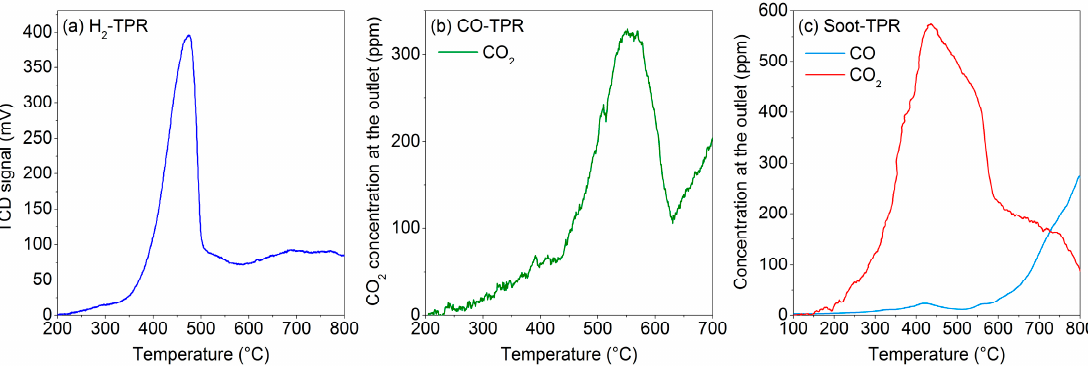
Figure 6. Results of the temperature programmed reduction analyses performed on the Ce50Pr50 catalyst: ( a ) H 2 -TPR, ( b ) CO-TPR and ( c ) Soot-TPR.